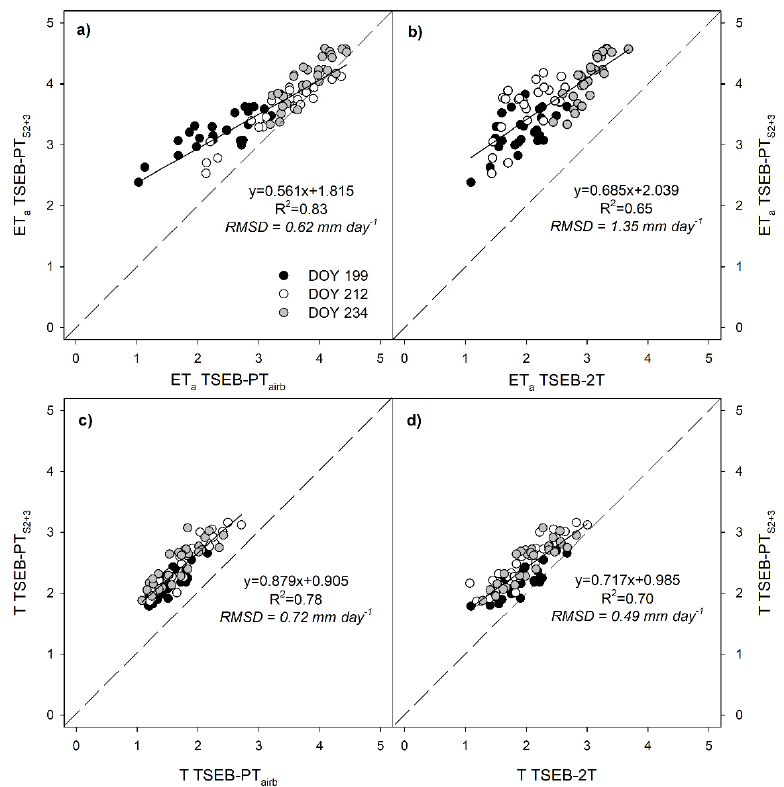
Figure 4. Scatterplots comparing estimates of actual daily evapotranspiration (ET a ) and transpiration (T) with the Priestley–Taylor approach using sharpened LST from Sentinel-2 and Sentinel-3 images (TSEB-PT S2 + 3 ) against ( a , c ) TSEB-PT airb and ( b , d ) TSEB-2T. The data were validated in the pixels containing the 32 measured vines relating to three dates: 18 th July (DOY 199), 31 st July (DOY 212) and 22 nd August (DOY 234).